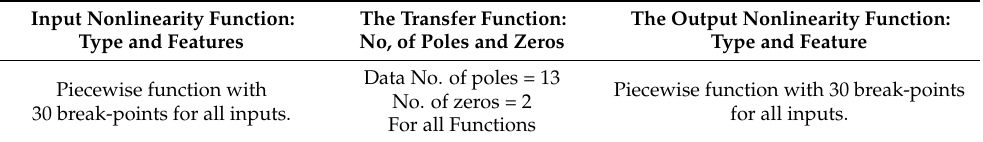
Table 1. The HW model description for the wind generator. Input Nonlinearity Function: Type and Features Piecewise function with 30 break-points for all inputs.